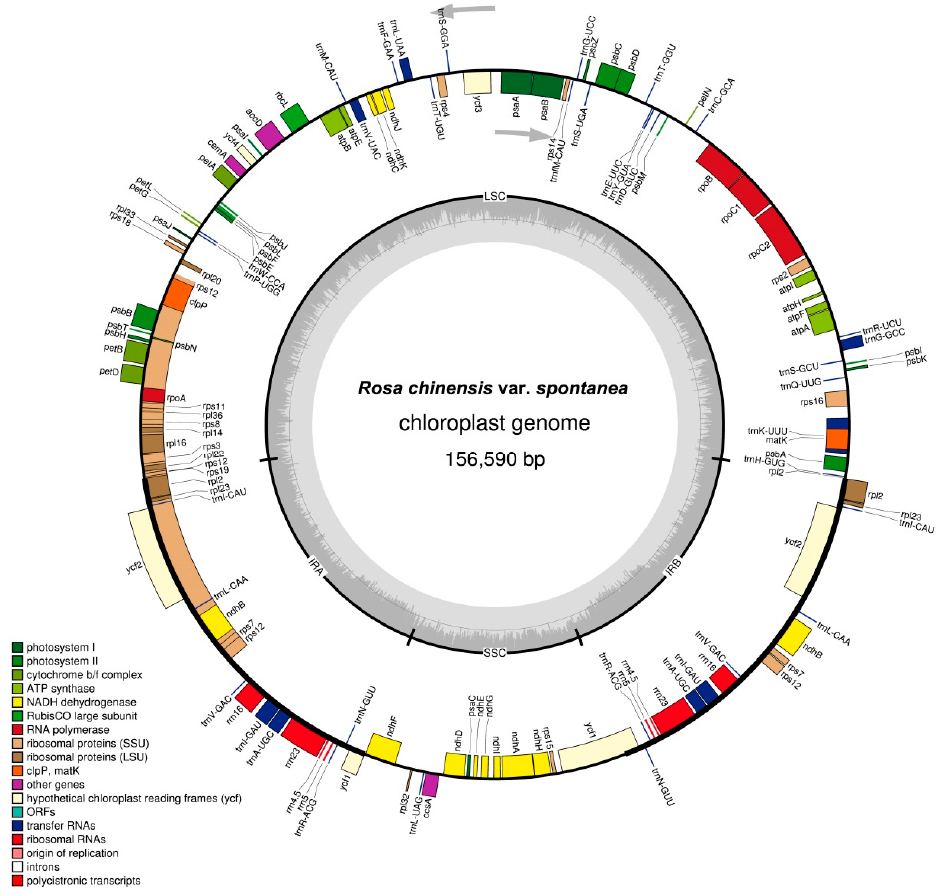
Figure 1. Chloroplast genome map of Rosa chinensis var. spontanea . Genes inside the circle are transcribed clockwise, and those outside are counterclockwise. Genes of different functions are color-coded. The darker gray in the inner circle shows the GC content, while the lighter gray shows the AT content.